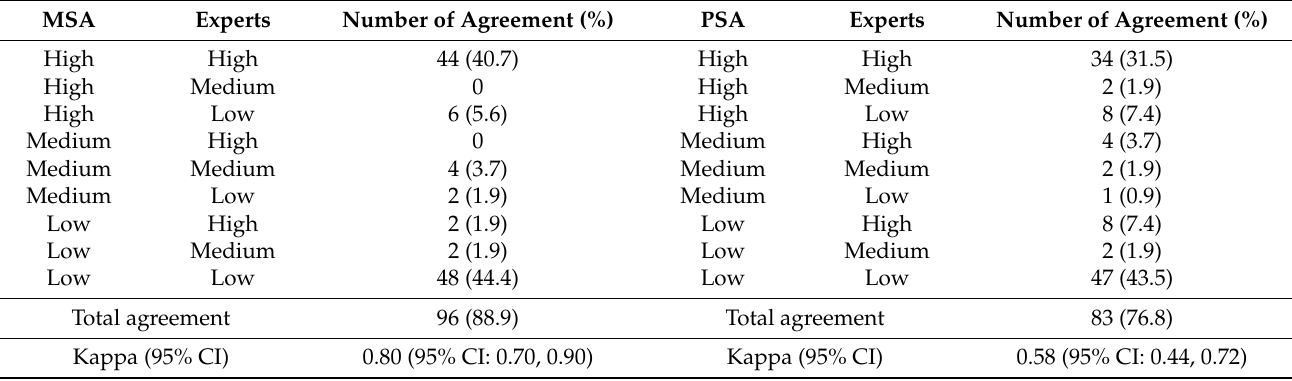
Table A4. Kappa calculation formula and calculation